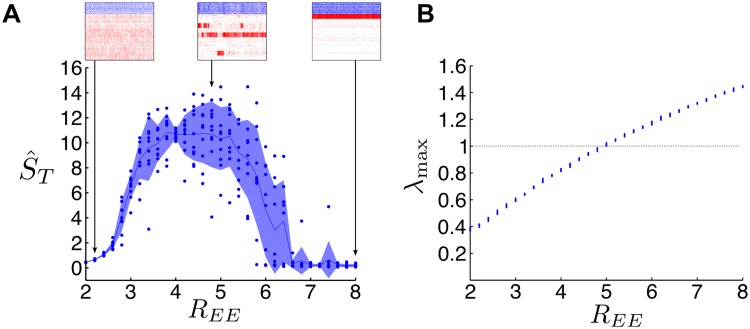
Effect of large clustering strength on SSA activity.
A Large values of the clustering R
EE lead to linear instability of the SSA dynamics and localization of the activity on one assembly. As measured by the spike rate variability across time (S^T), the increase of R
EE leads to SSA (signalled by the increased value of S^T). If the clustering increases further, S^T decreases, as the dynamics becomes dominated by one assembly only. (dots: raw data from simulations; line: mean; shading: standard deviation). Inset: examples of raster plots for three data points in the three regimes. The analysis corresponds to a clustered LIF network of 1000 neurons. B Plot of the eigenvalue with the largest real component λ
max against the clustering strength R
EE. The linear condition λ
max > 1 is a good indicator of the dynamics becoming dominated by one cell assembly.